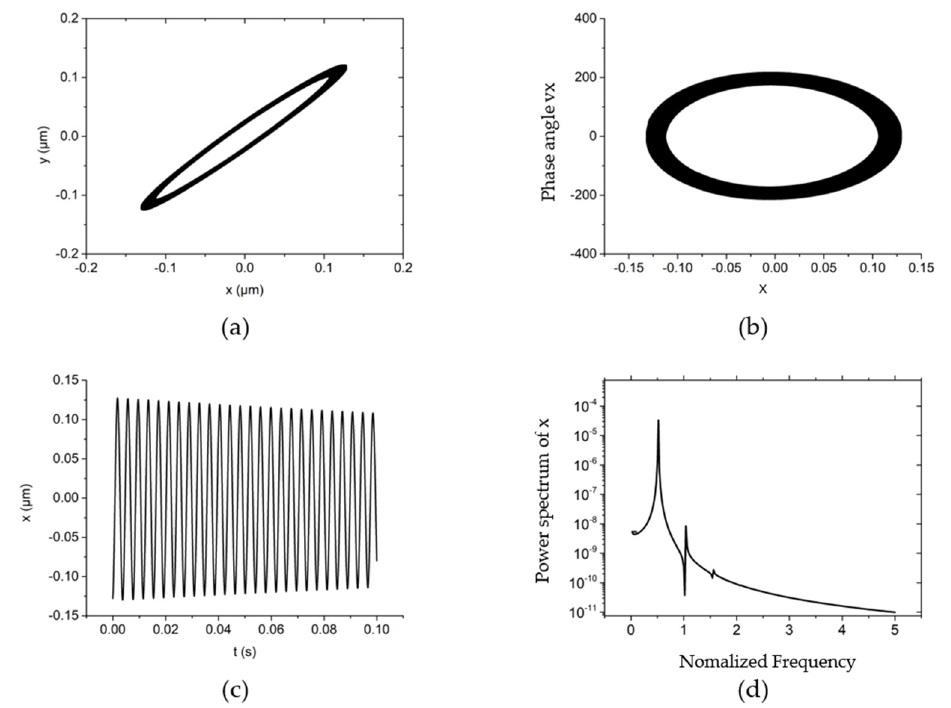
Figure 5. The nonlinear dynamic behavior of the rotor at w = 50,000 r/min, Fy = 10 N, m u = 0.01 g, m = 90 g. ( a ) Rotor center trajectory, ( b ) Phase angle in x direction, ( c ) X displacement time-domain curve, ( d ) Power spectral density in the x direction.